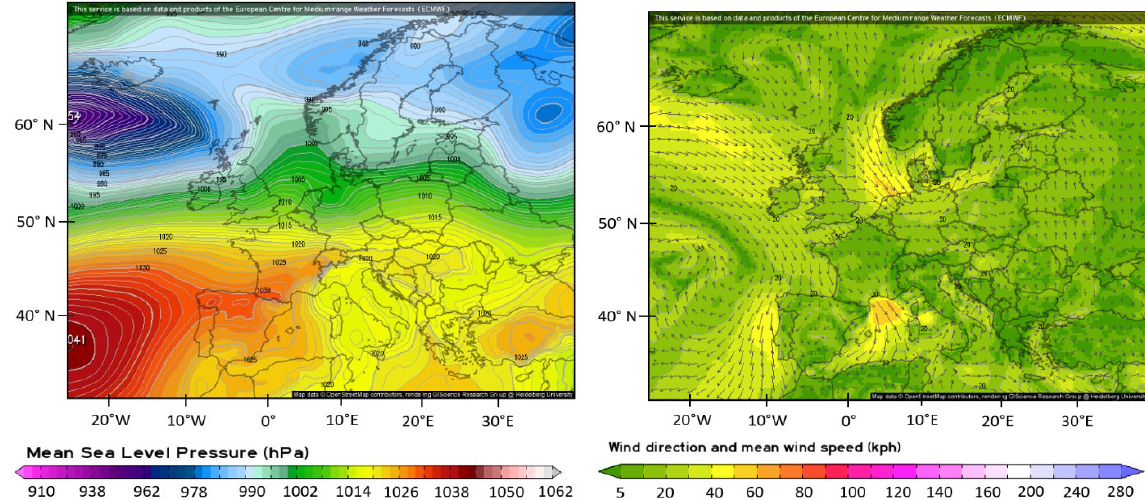
Figure 3. Sea-level pressure (left) and 10 m wind directions and speeds by ECMWF reanalysis for 17 August 2021. On the left, colors indicate the mean sea-level pressure and lines highlight the isobars. On the right, arrows indicate the wind direction and the colors indicate the wind speeds. Source: (meteorologix.com, accessed on 8 February